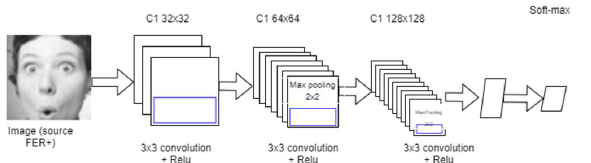
Figure 7 . The architecture of the